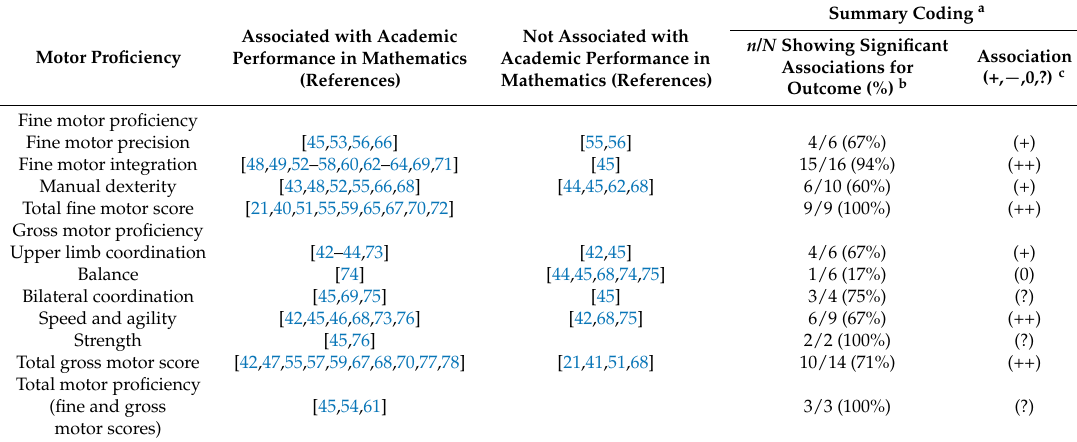
Table 1. Overall levels of evidence from studies examining associations between specific components of motor proficiency and academic performance in mathematics in school-aged children and